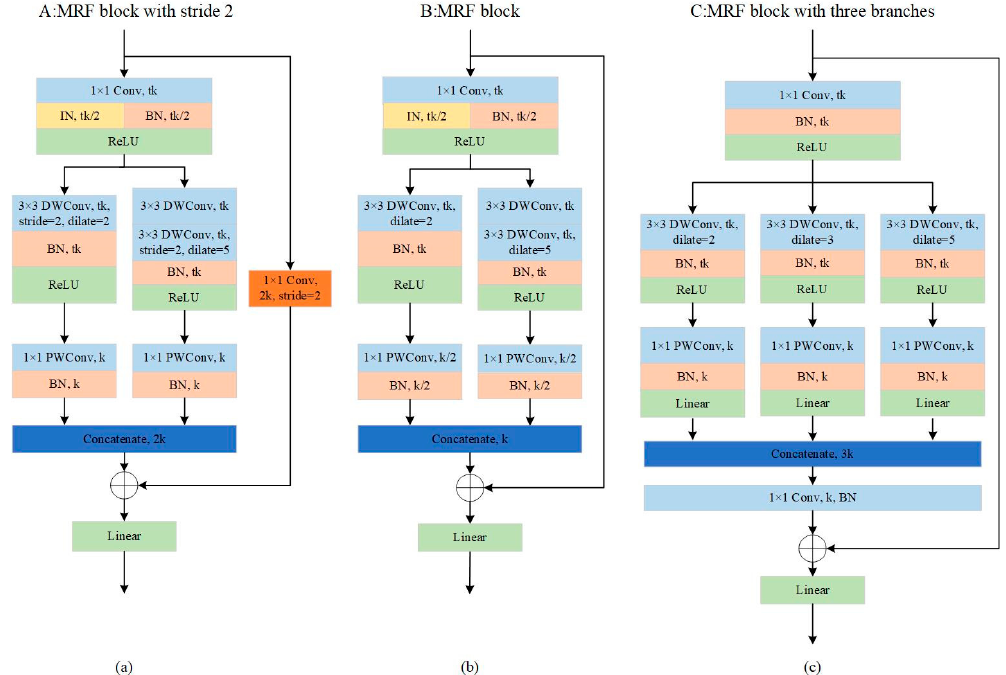
Figure 6. The MRF block, where k is the number of input channels, and t is the expansion factor to increase channels. ( a ) The MRF block with stride 2, which reduces the size of feature map by half and doubles the number of channels; ( b ) the MRF block; ( c ) the MRF block with three branches that have different dilated rates.